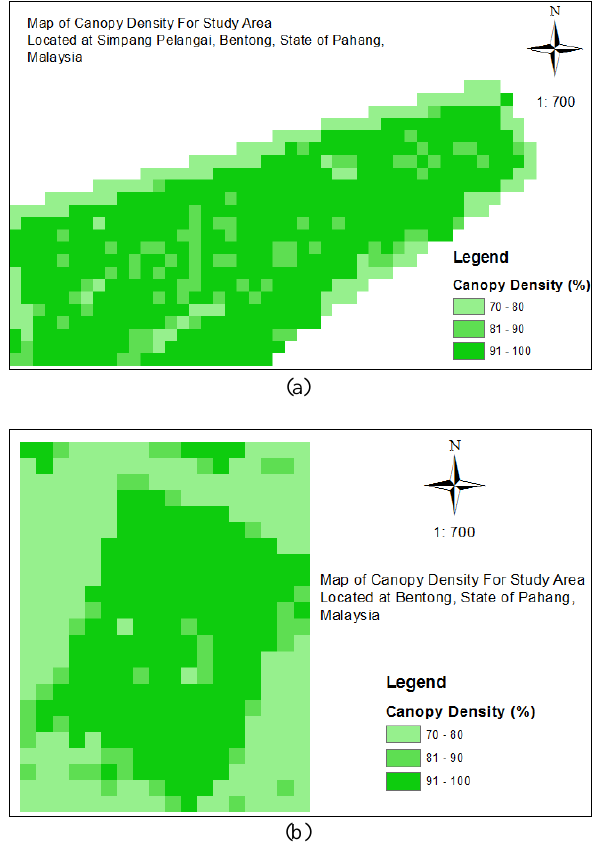
Figure 9. Canopy density map for (a) rubber trees area, and (b) mixed forest